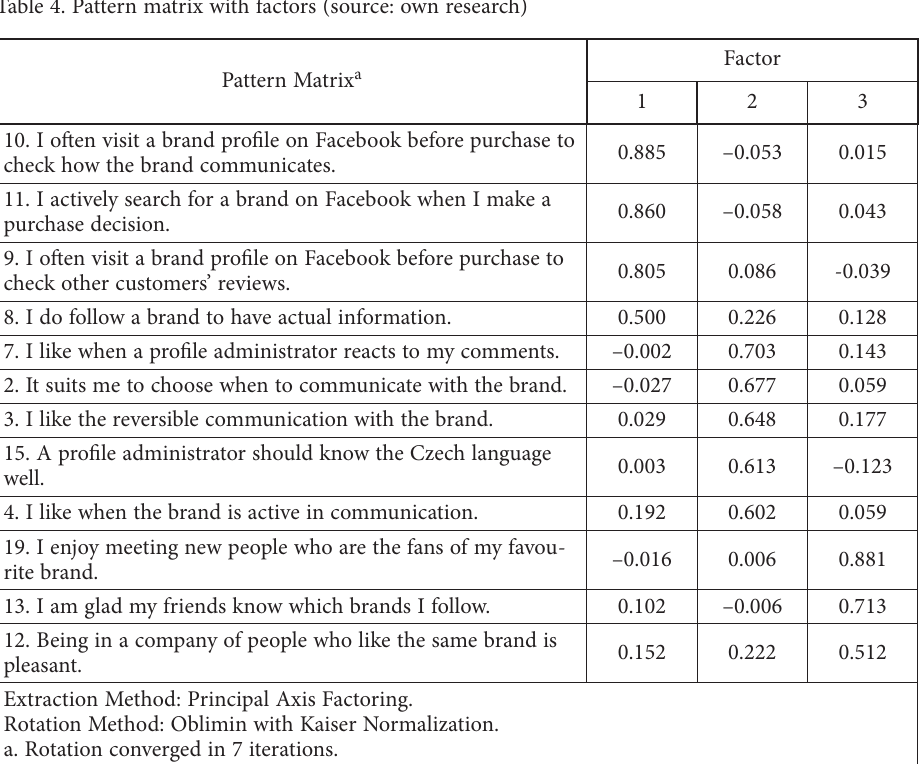
Table 4. Pattern matrix with factors (source: own research) Pattern Matrix